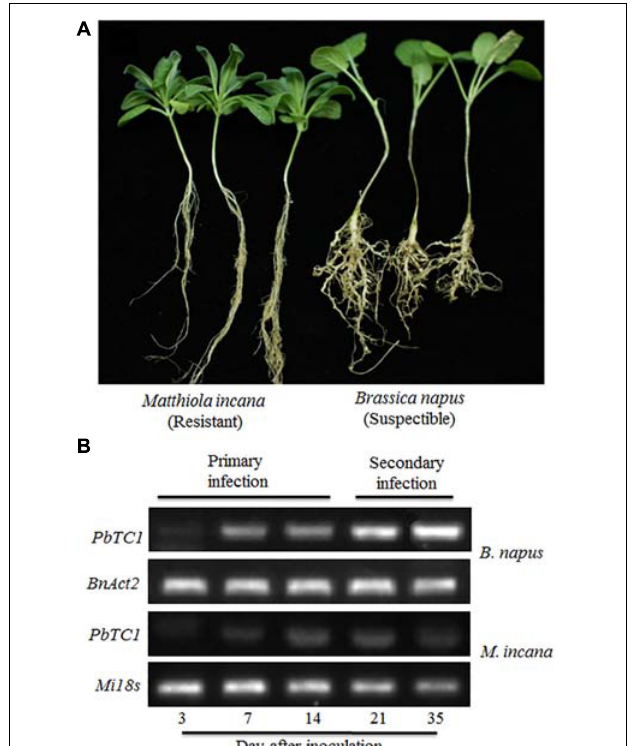
FIGURE 1 | Symptoms of clubroot disease in Brassica napus and Matthiola incana at 35 days after inoculation (DAI) (A) and PCR detection of P. brassicae in the roots of B. napus and M. incana at 3, 7, 14, 21 and 35 DAI (B)